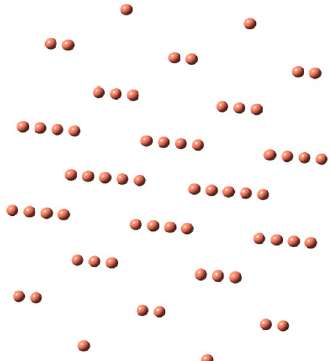
Figure 1. Optimized Cu (fcc) structure (https:// chemi stry. com. pk/ softw are/ free- downl oad- chemd raw- ultra- 12/, https:// gauss view. softw are. infor mer. com/5.